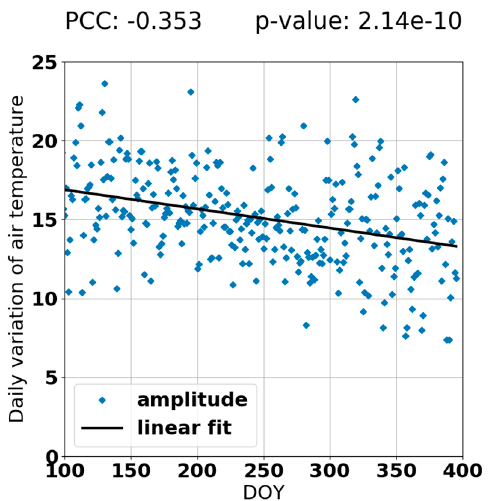
in 2017 in Bahariya (Egypt).